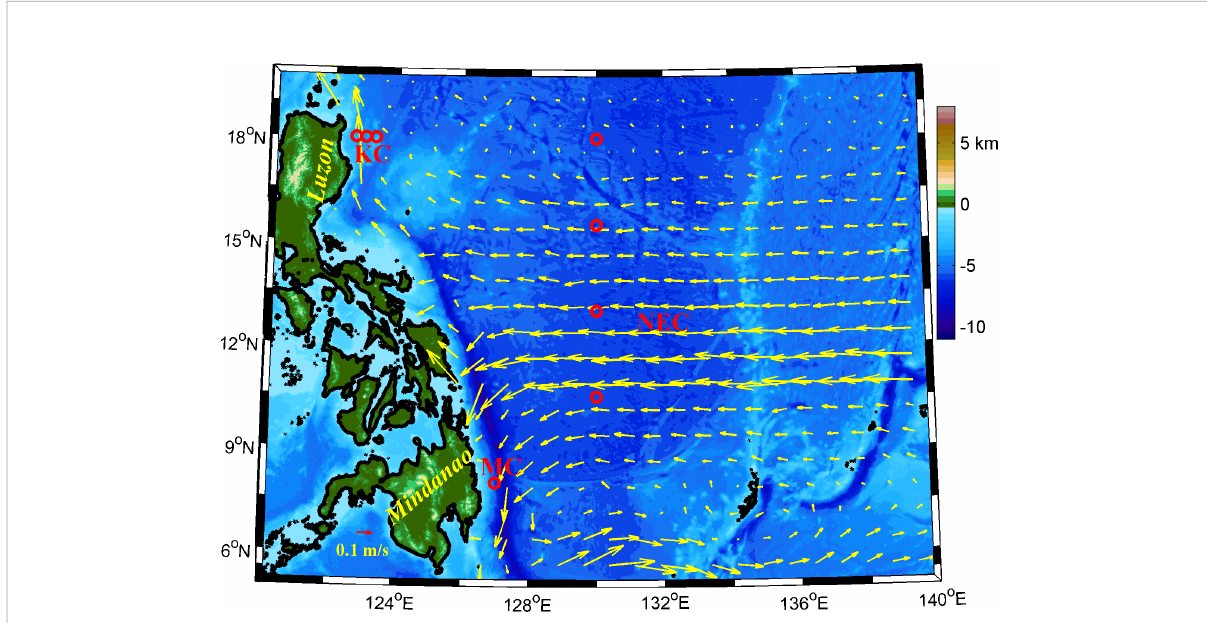
FIGURE 1 Bottom topography east of the Philippines. Red circles denote moorings at 10.5°N, 13°N, 15.5°N, and 18°N along 130°E; moorings at 122.7°E, 123°E, and 123.3°E along 18°N; and mooring at 127°E/8°N. The arrows represent the mean geostrophic currents from satellite data (1993 – 2019).